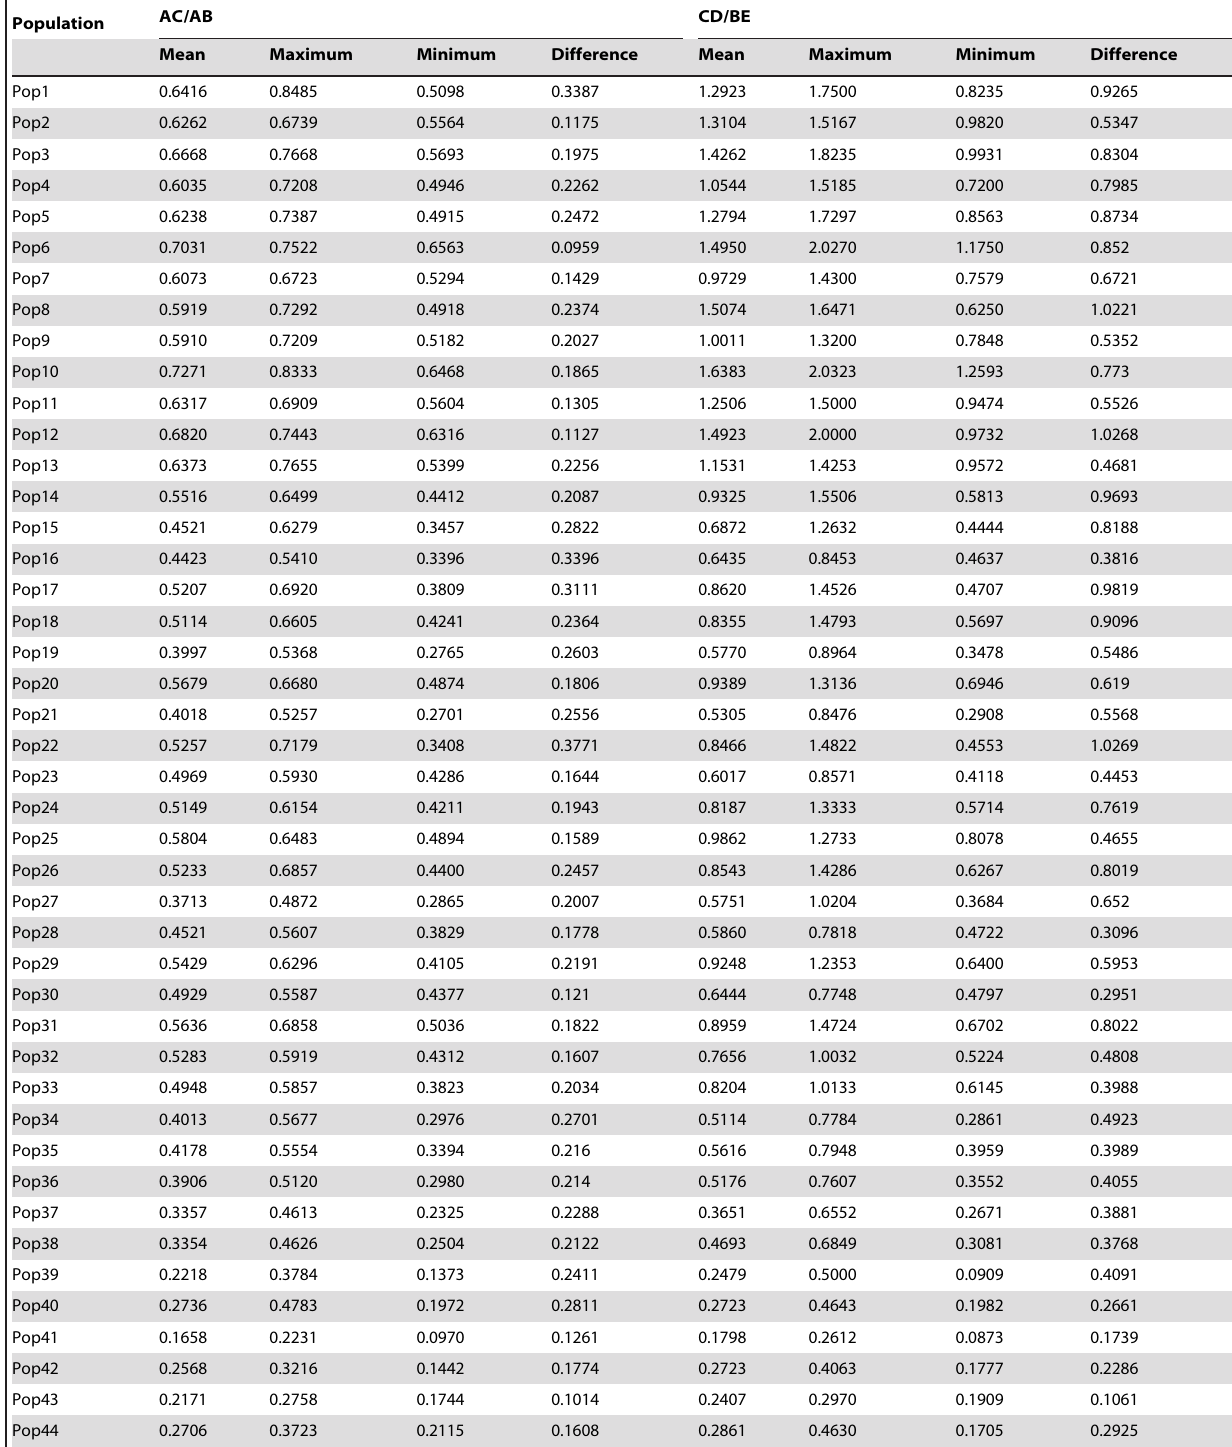
Table 5. AC/AB and CD/BE value at population